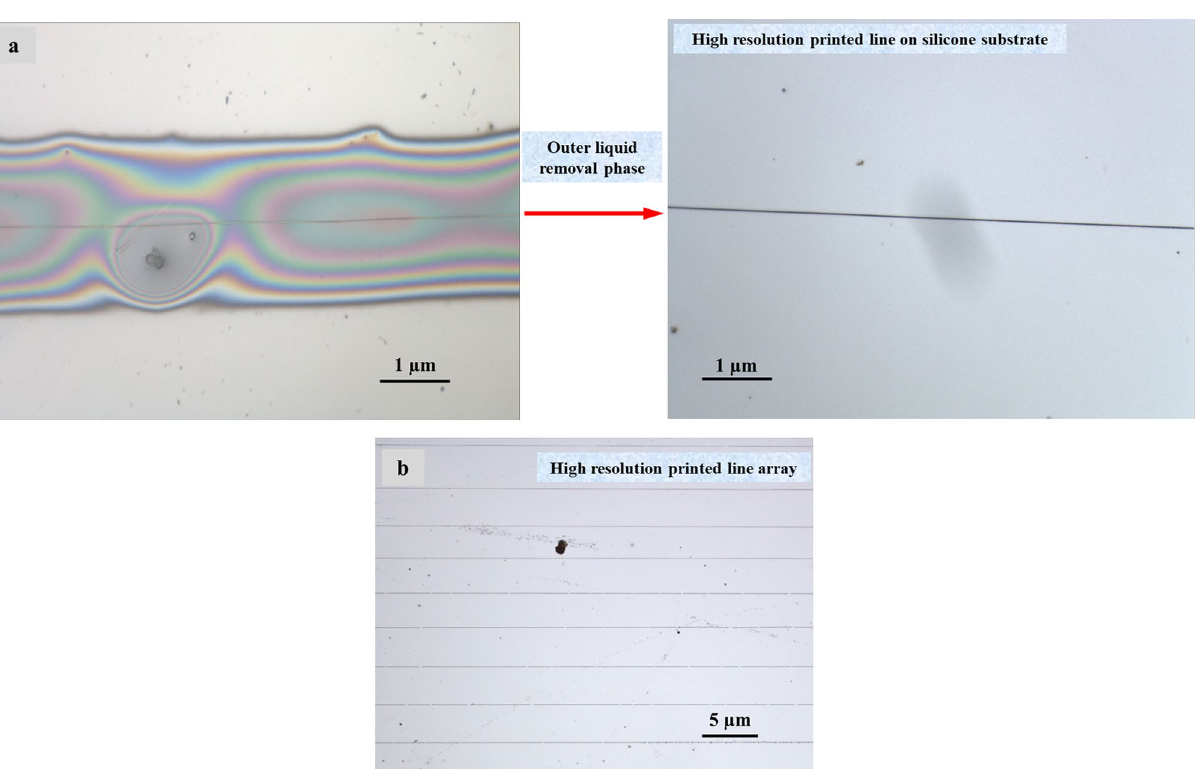
Figure 17. ( a ) The two-layer structure printed using CE-Jet with photoresist as the inner ink and silicone oil as the outer solution and ( b ) the printed line from 50 to 400 mm∙s −1 , the print structure size is reduced from 10 to 5 µm. Stable CE-Jet is a continuous fluid flow and CE-Jet between the materials is printed on substrate because the outer layer of liquid is a highly viscous solution. The movement of Jet between the needle and substrate is mechanically dragged (see Fig. 16). As the substrate speed increases, then mechanical drag force increases and the Jet is drawn more finely. At the same time, increasing substrate speed will also enhance the stability of Jet and improve the orderliness of printing